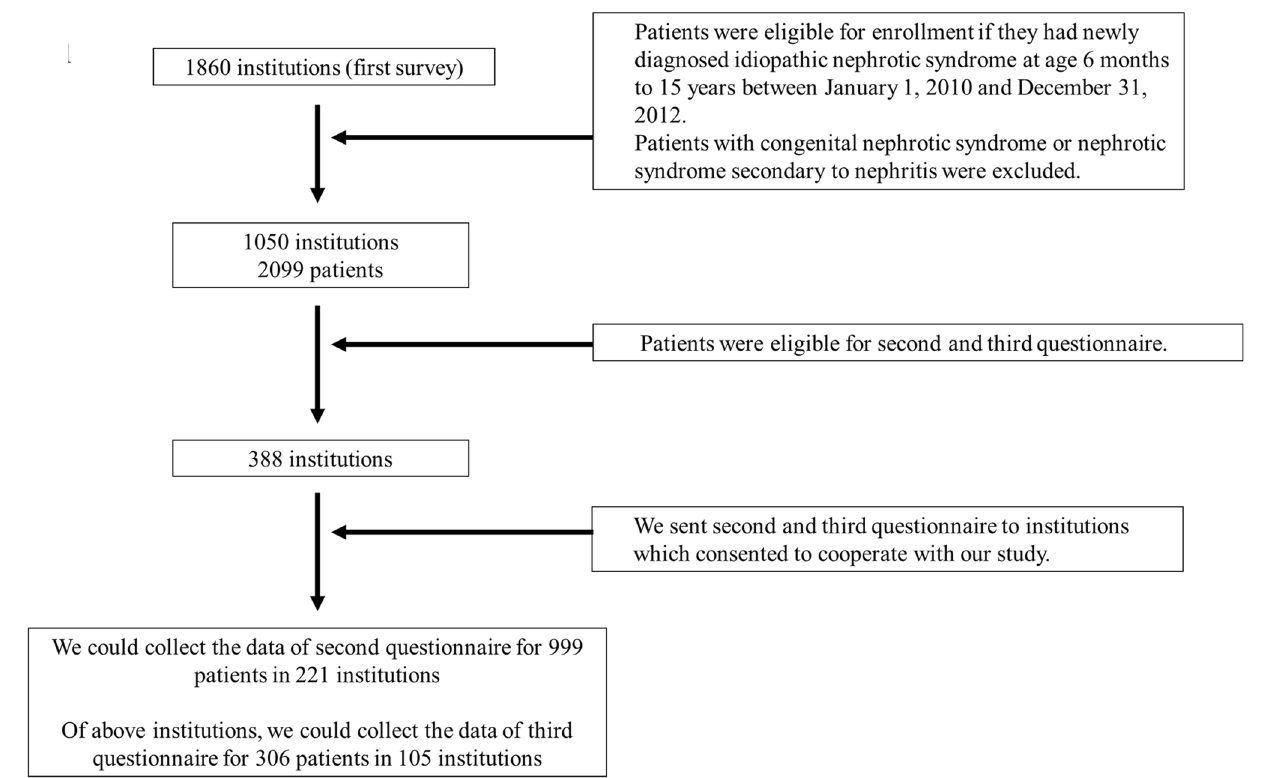
Figure 1. Flow chart of study design and populations. Of 388 institutions, 105 responded to the third questionnaire and data were collected for 306